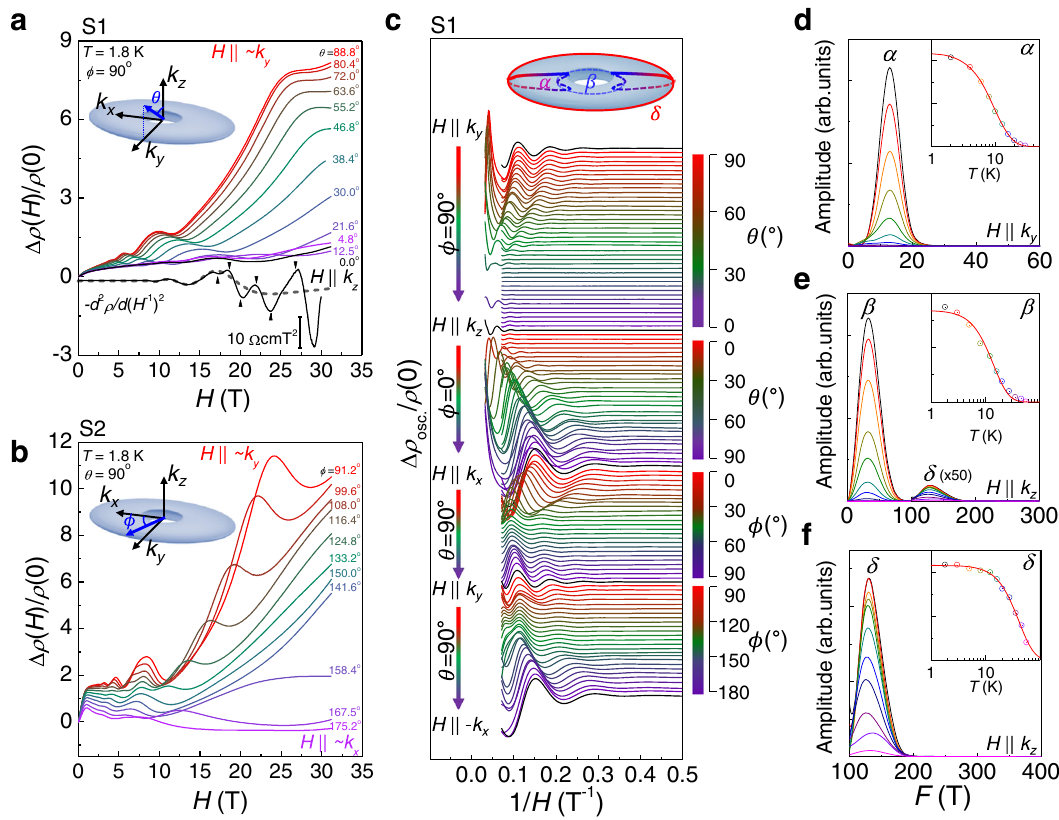
Fig. 2 | Shubnikov-de Hass oscillations of SrAs 3 . a , b Magnetoresistance (MR) planes of ( k x , k y ), ( k y , k z ) and ( k x , k z ) for S1. The inset shows torus-shaped Fermi fi eld orientations in the ( k Δ ρ ( H )/ ρ (0) of SrAs surface of SrAs 3 with the poloidal orbit ( α ) and the inner ( β ) and outer ( δ ) toroidal 3 with different magnetic y , k z ) plane ( a , S1) and in the ( k x , k y ) plane ( b , S2).The second derivative of ρ ( H ) with respectto orbits. d , e , f FastFouriertransform(FFT)amplitudesfor α orbit( d ),and β orbit( d ) 1/ H at H ∥ k z is also shown in a . The overlaid dashed gray curve corresponds to the and δ orbit( f ),takenatvarioustemperaturesfor H ∥ k y ( d )and H ∥ k z ( e , f ).Theinsets coexistingSdHoscillationswithalowerfrequency.Theblackarrowsindicatepeaks show the temperature-dependentFFTamplitudes,togetherwiththe fi ts(redlines) and deeps of the higher-frequency oscillations. The polar ( θ ) and azimuthal ( ϕ ) totheLifshitz – Kosevichequation.In e ,theFFTamplitudeofthe δ orbit, F >100T,is angles are de fi ned with respect to the torus-shaped Fermi surface as shown in the magni fi ed for insets. c SdH oscillations ( Δ ρ osc. / ρ (0)) at various magnetic fi eld orientations in the